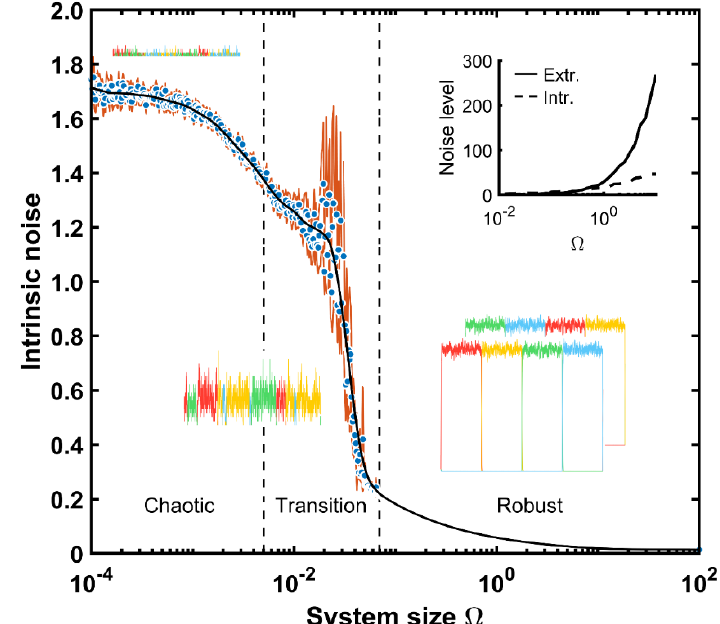
Figure 8. Intrinsic noise is given as the coefficient of variation based on the system size. Mean (blue dots) of 100 replicates, smoothed mean (black line), and the 95% confidence interval (red line) thereof are plotted. For each performance interval, a characteristic time evolution plot is also depicted. The inset plot shows the extrinsic (1% of k syn ) and intrinsic noise levels for different system sizes as the standard deviation under the same conditions, as explained in Figure 7.